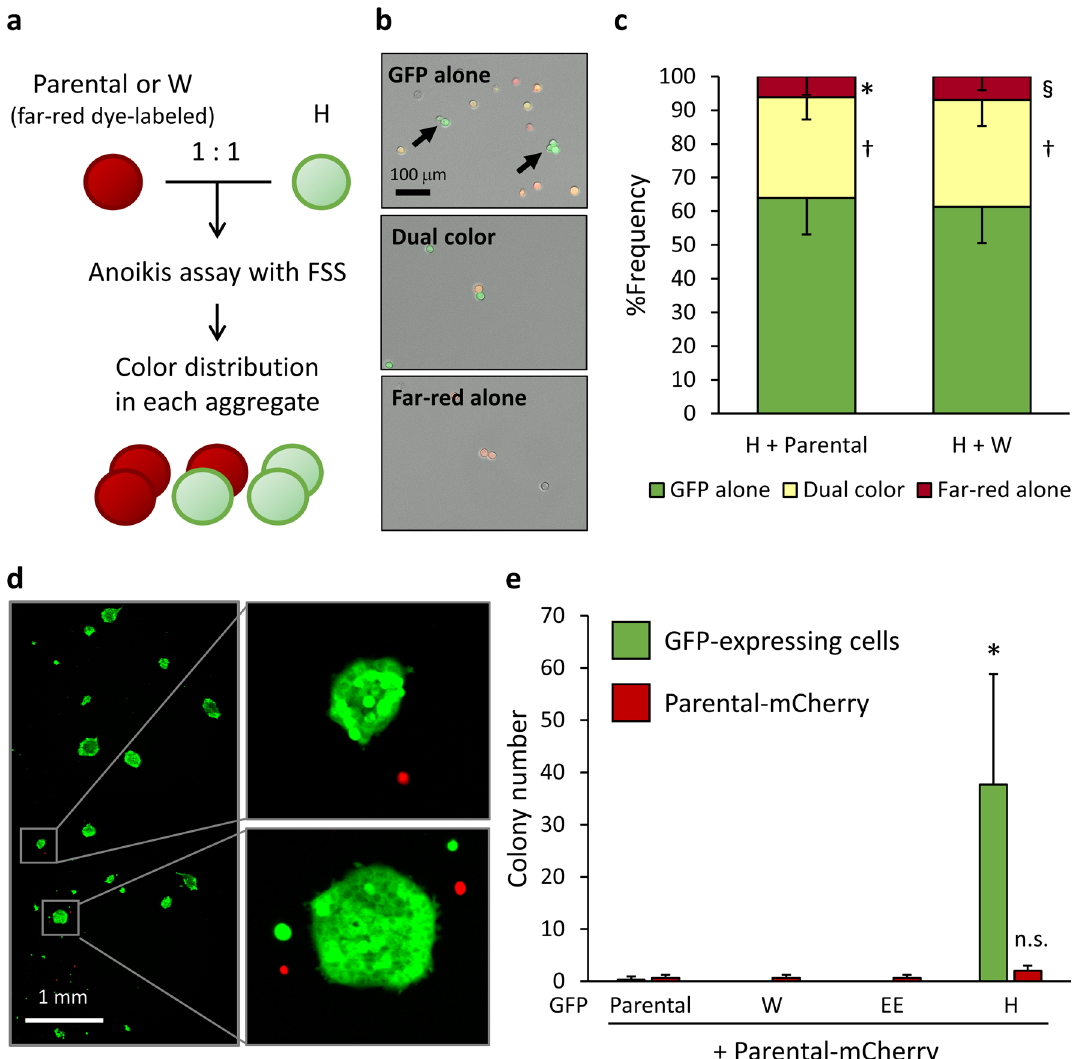
Figure 5. Clonal selection by homotypic cell aggregation in suspension with FSS. ( a ) Equal numbers of far-red-labeled GFP-expressing parental cells or clones W and H cells were mixed and suspended in culture medium followed by rotation for 3 h at 37 °C. ( b ) Representative images of cell aggregates composed of only GFP-expressing cells (upper), the mixture of GFP-expressing cells and far-red-labeled cells (middle), and only far-red-labeled cells (bottom). ( c ) Abundance ratio of each aggregate type. Error bars represent SEM of triplicate samples. * p < 0.005; † p < 0.01; § p < 0.0001 vs. GFP alone in each experimental group (two-tailed t tests). ( d , e ) Equal numbers of mCherry-expressing parental (Parental-mCherry) cells and GFP-expressing parental cells and clones W, EE, or H were mixed and suspended in culture medium followed by rotation for 22 h at 37 °C. Cells were centrifuged, plated in 6-well plates, and cultured for 6 days. Colonies of surviving cells with areas > 2500 μm 2 were counted. ( d ) Representative images of colonies derived from the parental-mCherry and clone H cell mixture. ( e ) The number of GFP- or mCherry-positive colonies in each experimental group. Values are means ± SEM of triplicate samples. * p < 0.05 (vs. all other GFP-positive and mCherry-positive cells); n.s., vs. mCherry-positive cells in all other